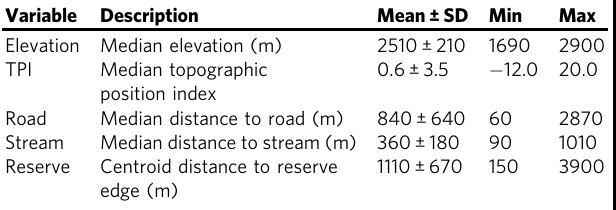
Table 4 Summary of environmental